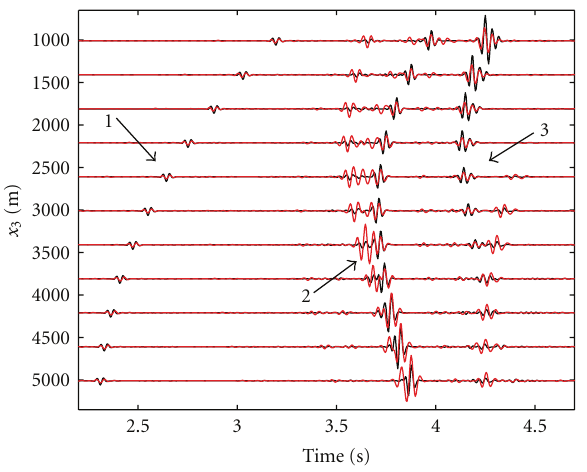
Figure 32: Migrated section of the salt flank from the CC data in a model with varying source spectra and a gas cloud; the location of the salt flank as taken from the velocity model is given by the red dashed line; markers A–G are discussed in the main text.